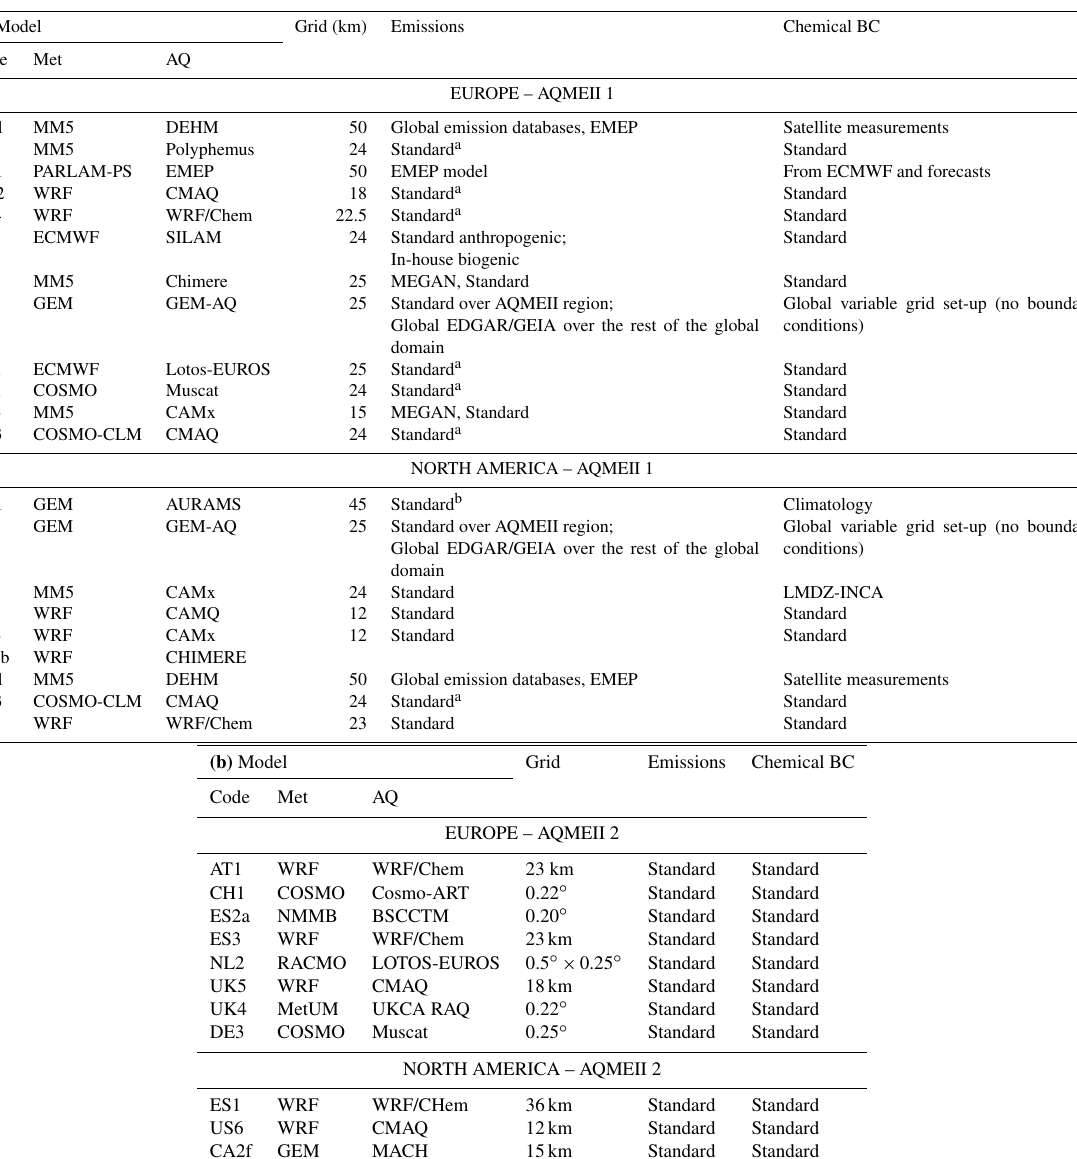
Table 2. Modelling systems participating in the first (a) and second (b) phases of AQMEII for Europe and North America. (a)